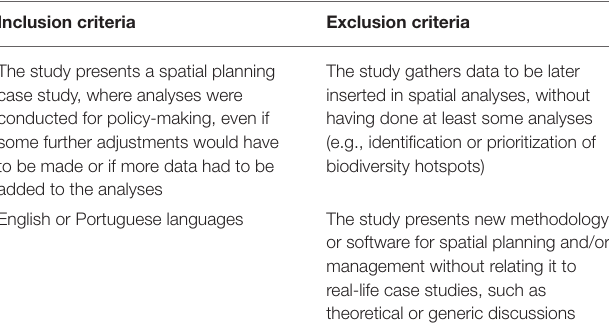
TABLE 1 | Inclusion and exclusion criteria used to select the studies for the